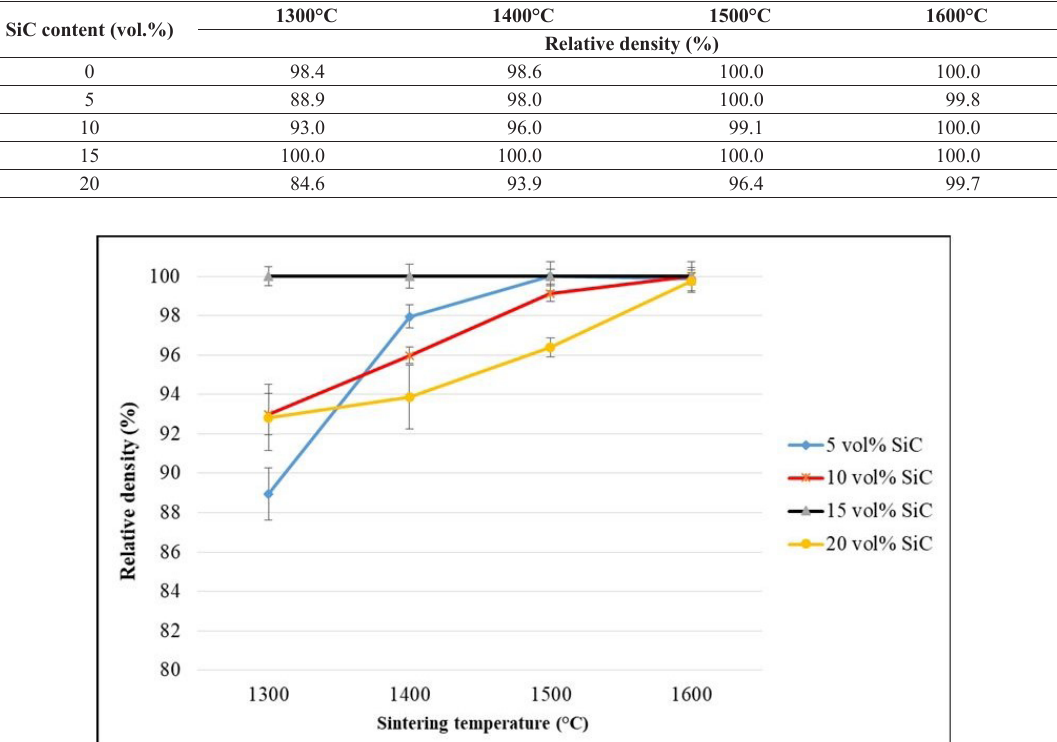
Figure 7: Relative density of Al